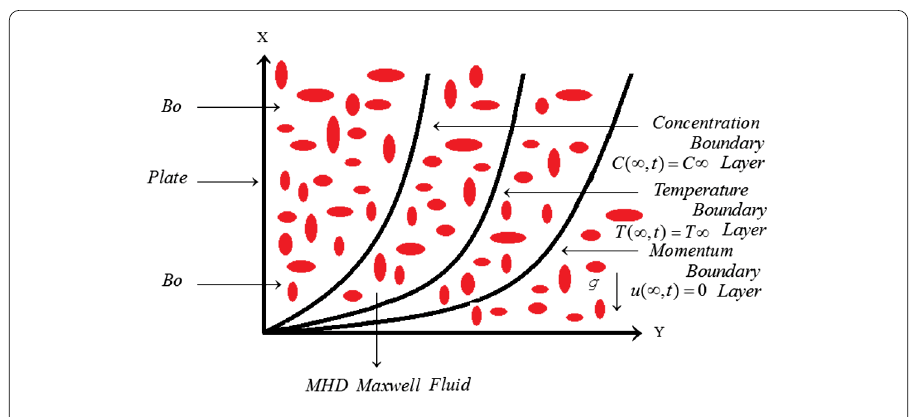
Figure 1 Geometrical formation of the flow